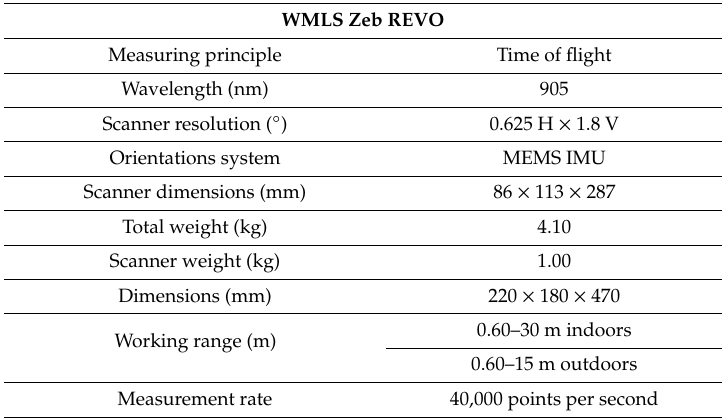
Table 6. Technical specifications of the Wearable Mobile LiDAR System